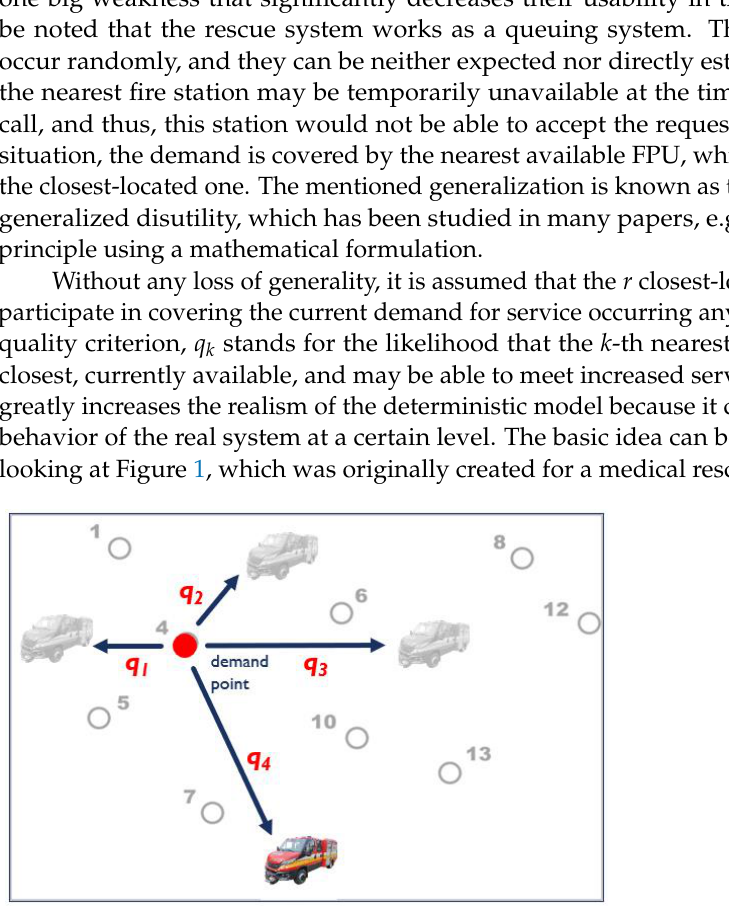
Figure 1. The main idea of generalized disutility.